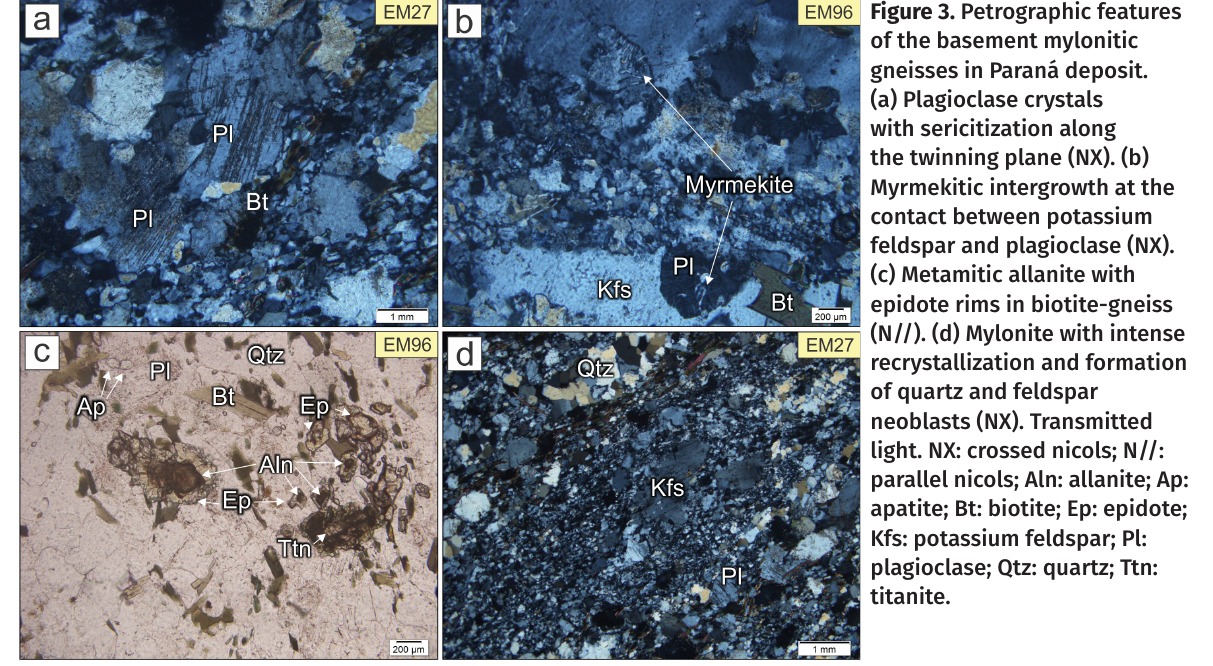
bluish-green colors; sections with two cleavage traces are common.